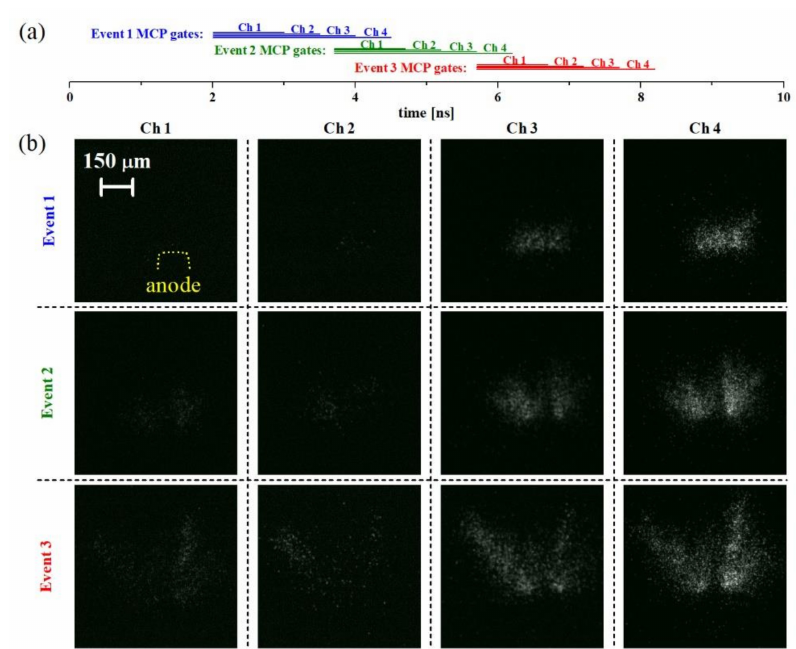
Figure 10. Case study B; image sequences obtained using the discharge emission that passes through the λ c = 656 nm interferential filter. Horizontal bars in ( a ) labelled as Ch1–Ch4 illustrate the timing of the Ch1–Ch4 MCP gates with respect to the onset (time t = 0 ns) of the HV pulse. Images in panel ( b ) show the evolution of selected events during the primary HV pulse acquired by using the Ch1, Ch2, Ch3, and Ch4 MCP gates of 1, 1.5, 2, and 2.5 ns, respectively.